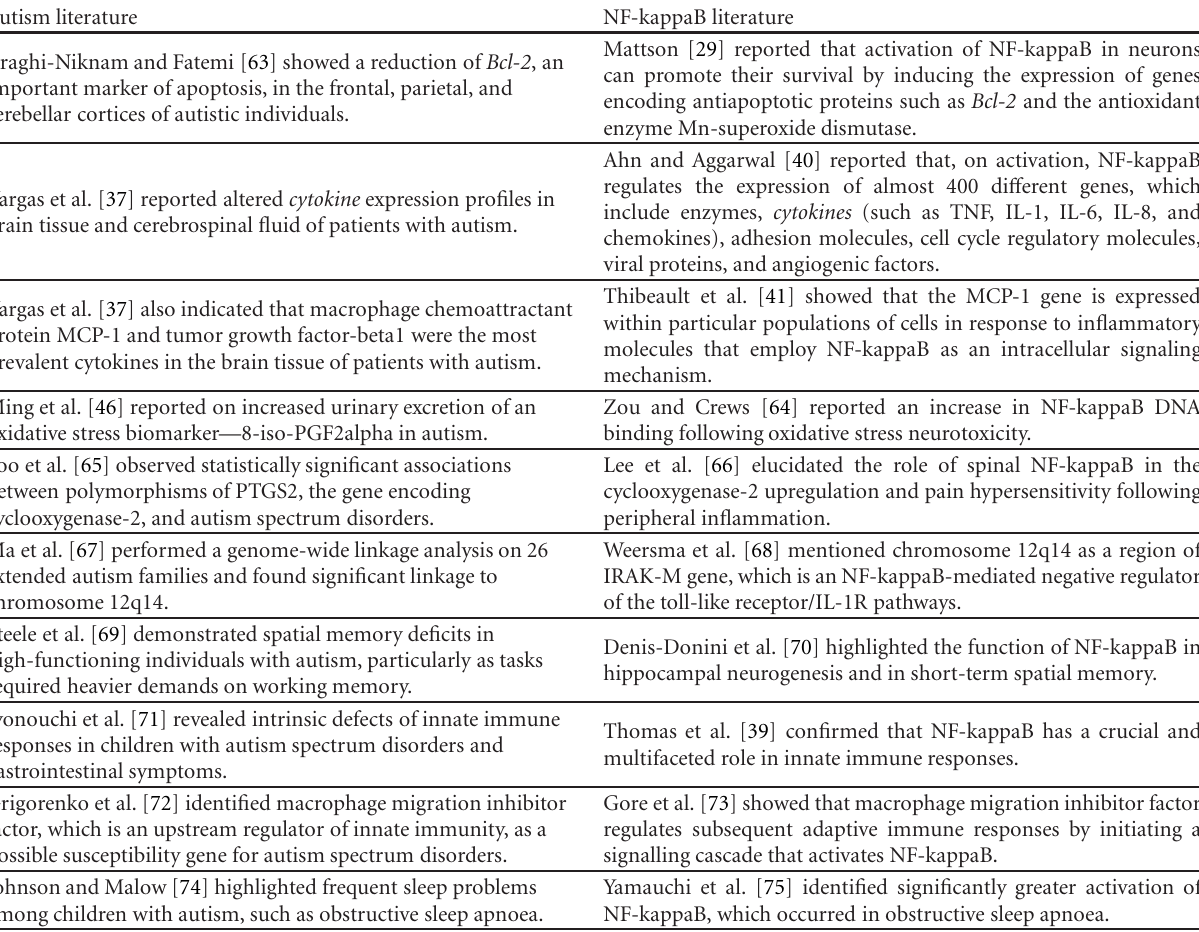
Table 2: Potential hypotheses for the relationship between autism and